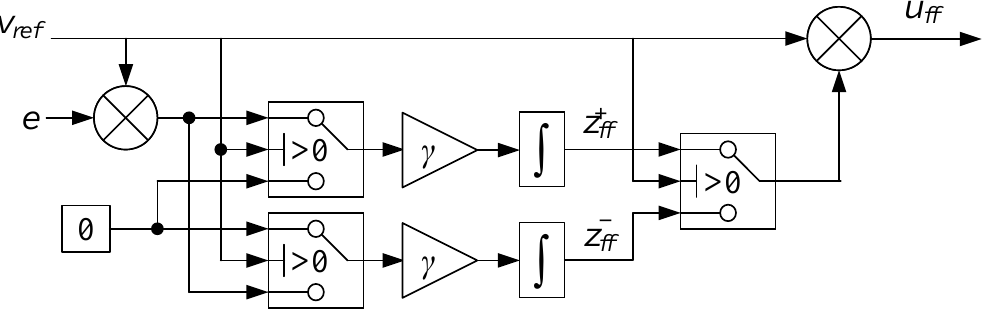
Figure 13. Differential MIT-rule adaptive